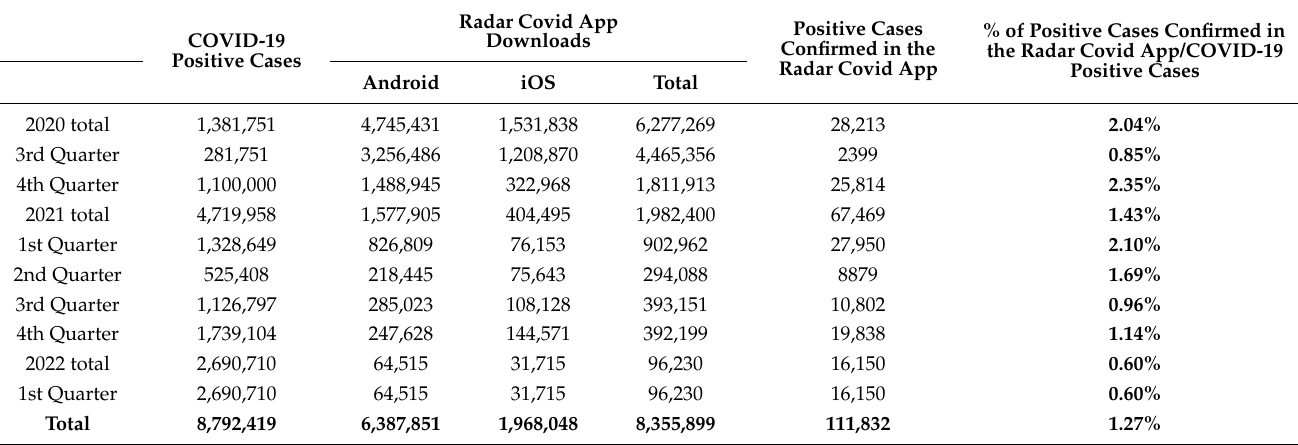
Table 1. Statistics of Radar Covid usage; Radar Covid App downloads and positive cases confirmed in Radar Covid are obtained [20,21]; COVID-19 positive cases in Spain were obtained from